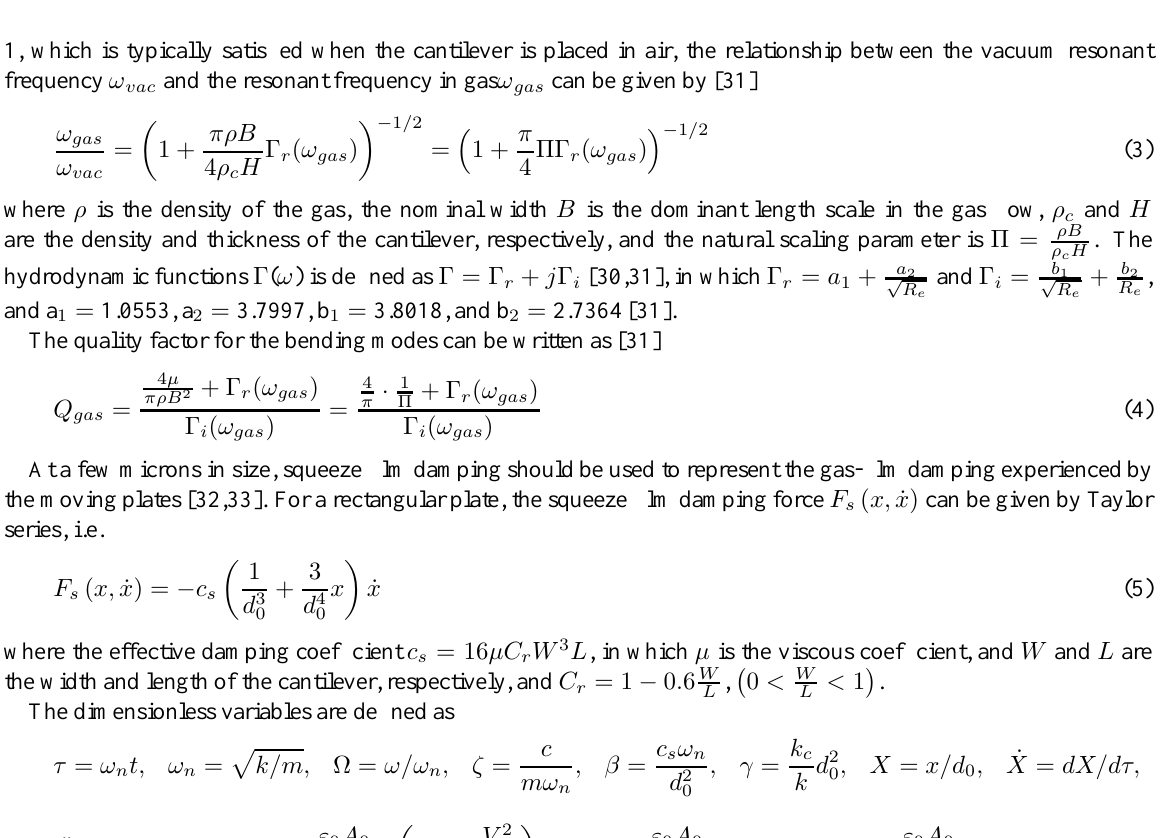
Fig. 1. Simplified dynamic model of a micromechanical electrostatic